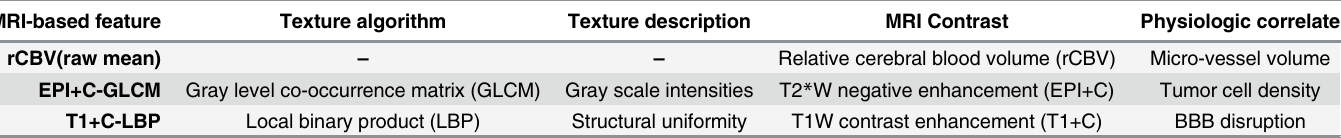
Table 2. Summary of selected MRI-based texture features to optimize CV training